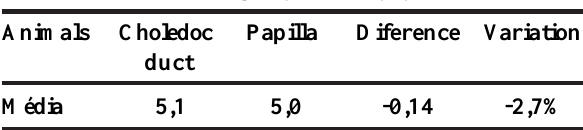
TABLE 2 - Average of measures (mm), absolute difference (mm) and percentual variation (%) of radiologic images of choledoc duct and dilation balloon in the location of major duodenal papilla in the animals of group A (with papilla dilation) Animals